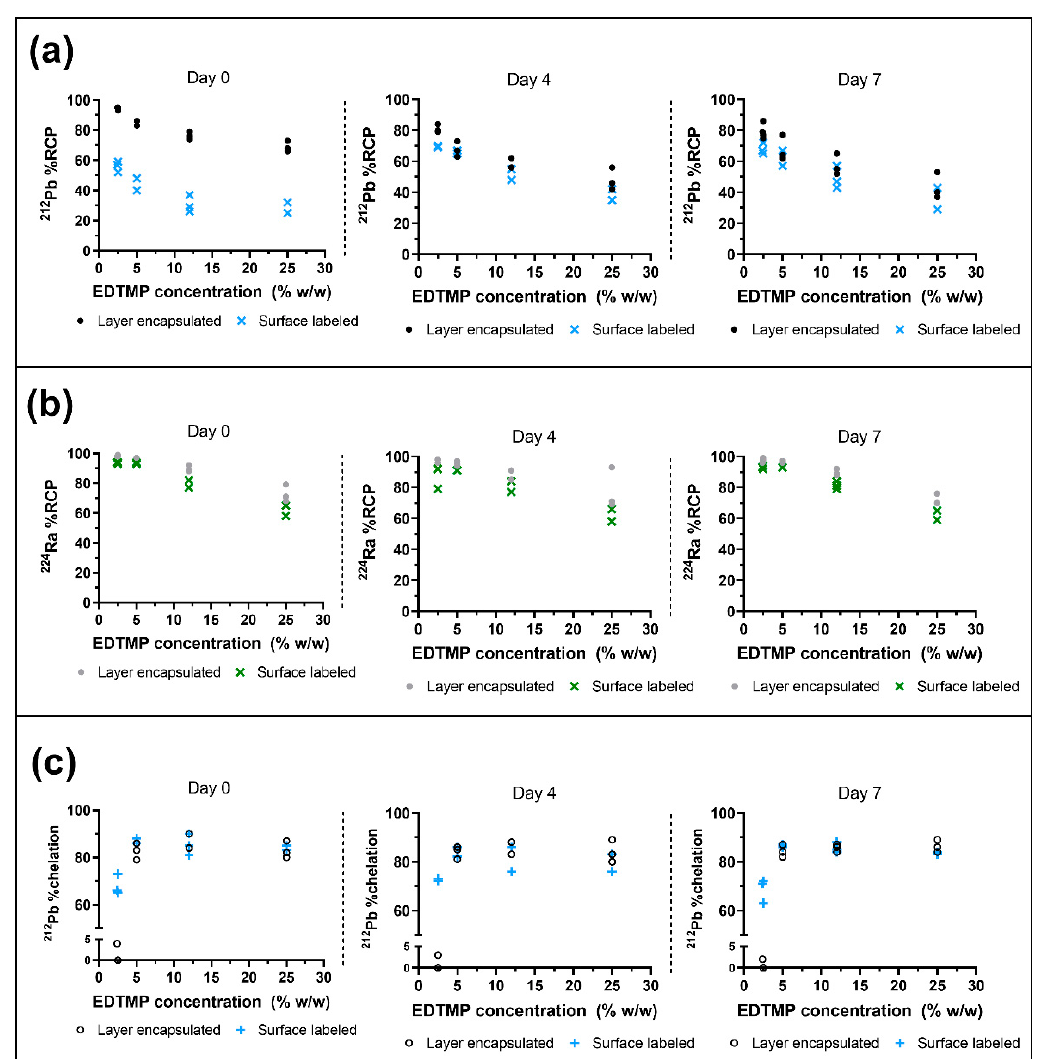
Figure 4. Radiochemical analysis of adsorbed 212 Pb and 224 Ra on CaCO 3 microparticles (MPs) with varying EDTMP concentrations. Symbols represent independent samples and EDTMP concentration is relative to CaCO 3 . ( a ) Percentage of adsorbed 212 Pb (% RCP) on the MPs on different days after labeling, surface-labeled MPs vs layer-encapsulated surface-labeled MPs. ( b ) Percentage of adsorbed 224 Ra on the MPs (% RCP) on different days after labeling, surface-labeled MPs vs layer-encapsulated surface-labeled MPs. ( c ) Percentage of 212 Pb-EDTMP in the liquid phase after subtracting unspecific migration by 212 Pb 2+ in 0.9% NaCl in the ITLC setup on different days after labeling, surface-labeled MPs vs layer-encapsulated surface-labeled MPs.